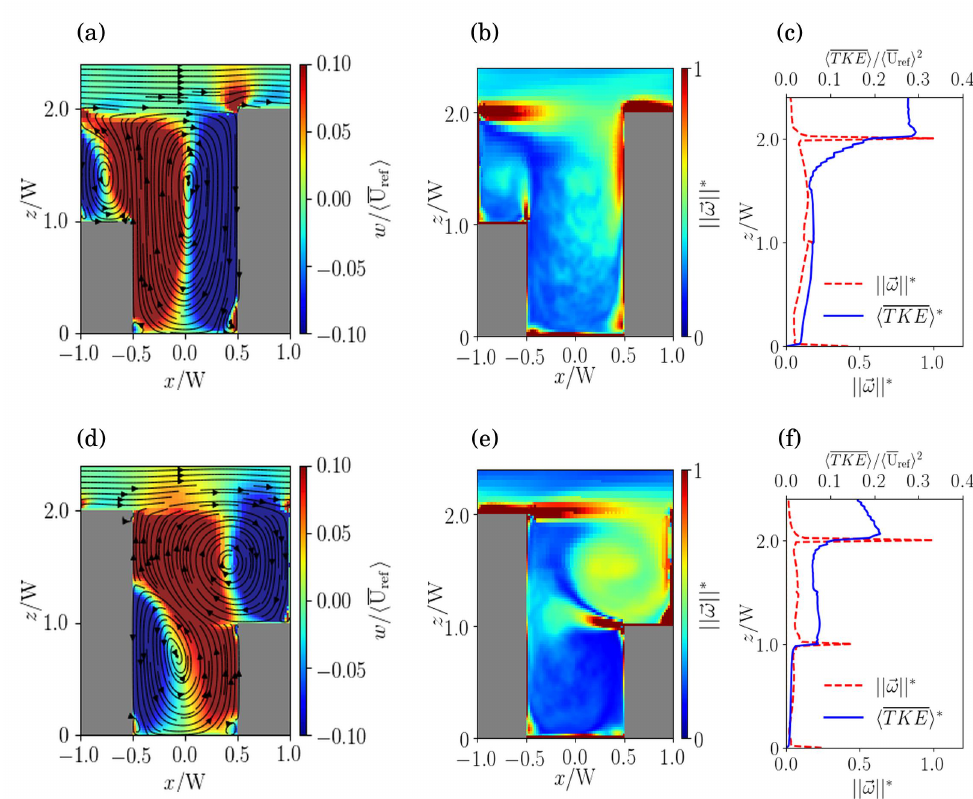
Figure 9. As in Figure 4 but for asymmetric canyons. ( Top ) step-up canyon ( BR = 2); ( bottom ) step-down canyon ( BR = 0.5). ( a , d ) Temporally and spatially averaged streamlines; ( b , e ) spatially averaged vorticity magnitude; ( c , f ) vertical profiles of the normalised TKE and vorticity magnitude.